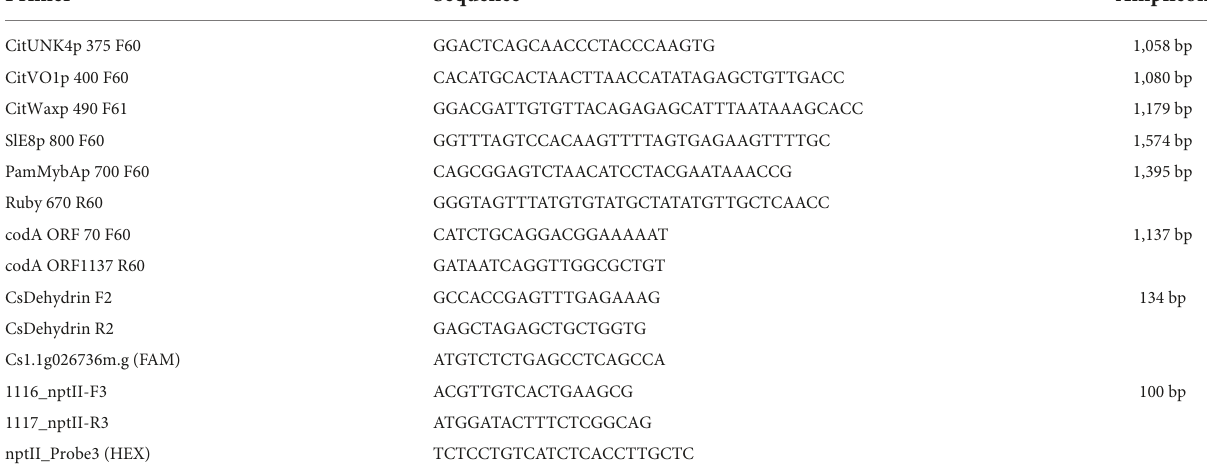
TABLE 4 Primers and probes used in PCR and